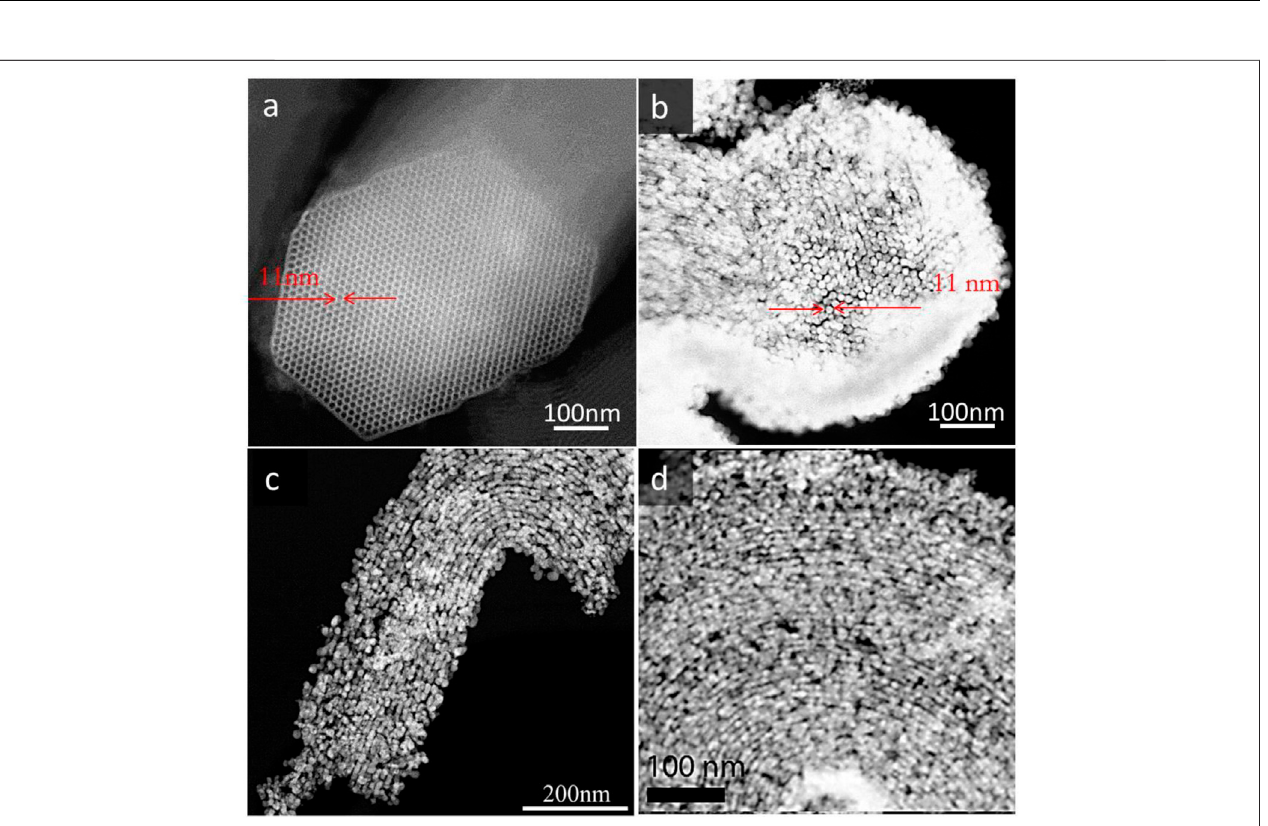
FIGURE 12 | HAADF-STEM image of the parent zeotile-4 (A) and that of its platinum replica (B) along the cross section showing the hexagonal rods being exact replications of the main channels with platinum. Lateral views of the replica (C,D) showing the small struts of Pt lining up with the main rods being replicas of the interconnecting narrow pores (reproduced from Pulinthanathu Sree et al., 2017 with permission from the Royal Society of Chemistry).